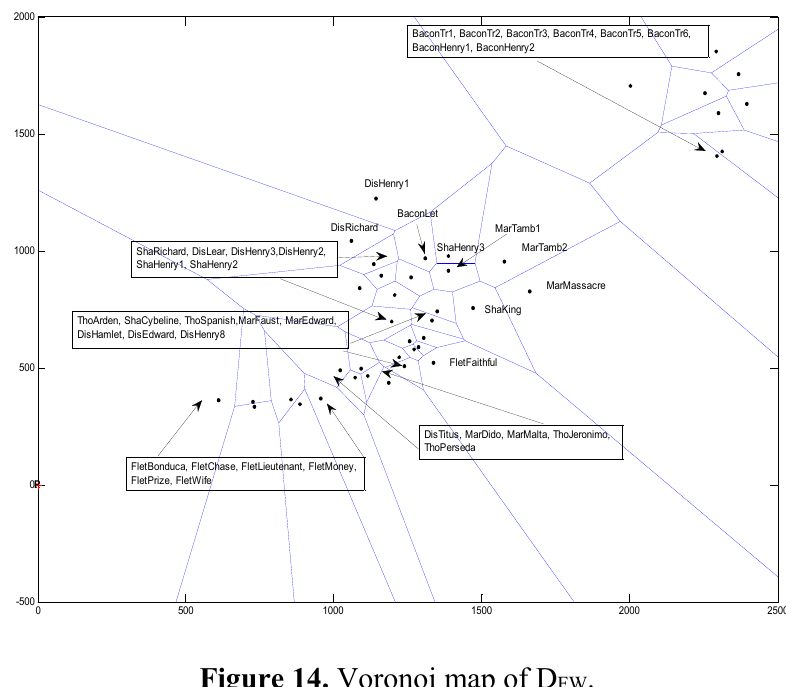
Figure 14. Voronoi map of D FW .